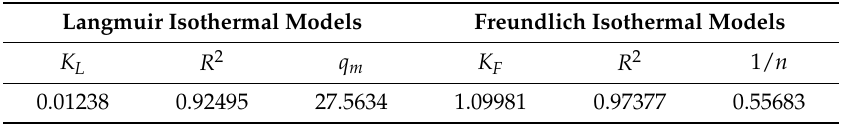
Table 2. Parameters for the Langmuir and Freundlich models of adsorption of Cu(II) ions on multi-structured SiO 2 @PVDF-HFP nanofibrous